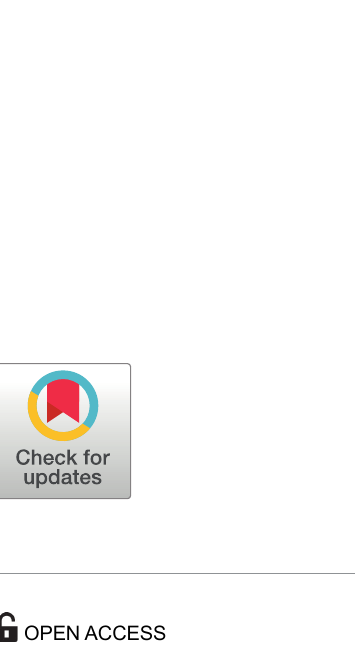
figshare.9696473.v1;https://doi.org/10.6084/m9. figshare.9696482.v1;https://doi.org/10.6084/m9. figshare.12030753.v1.Other